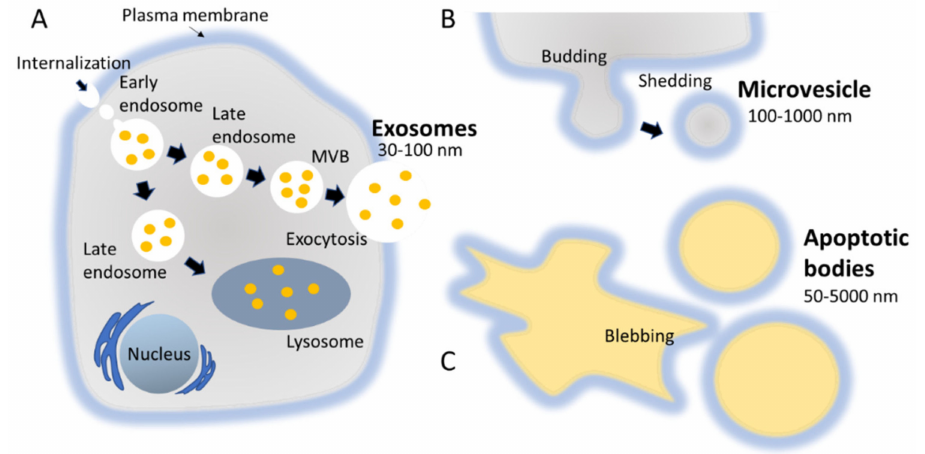
Figure 2. Biogenesis pathways followed by different types of EVs, namely exosomes, MVs, and ABs. ( A ) MVBs fuse with lysosomes and degrade or fuse with the plasma membrane and form exosomes which are released from cell into extracellular space. ( B ) MVs are a set of EVs with size in the range of 100–1000 nm; they are formed and released by budding off cell membrane. ( C ) ABs are in the size range of 50–5000 nm, and are released from cells undergoing